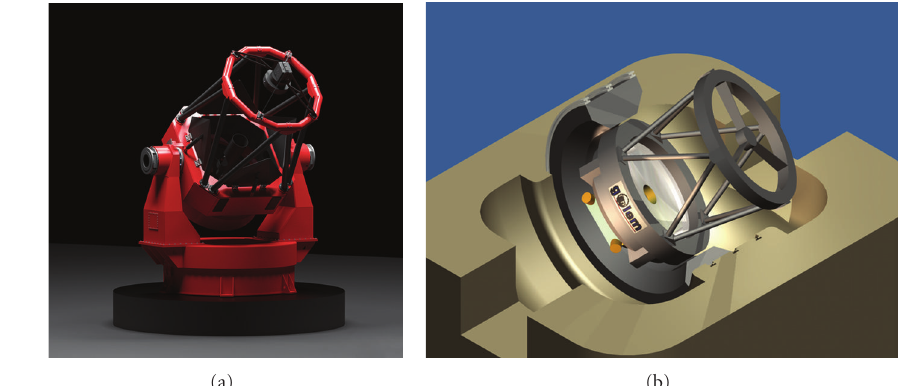
Figure 2: The Alt-Az (courtesy by Peter Aniol, Astelco) and Alt-Alt telescope configurations.